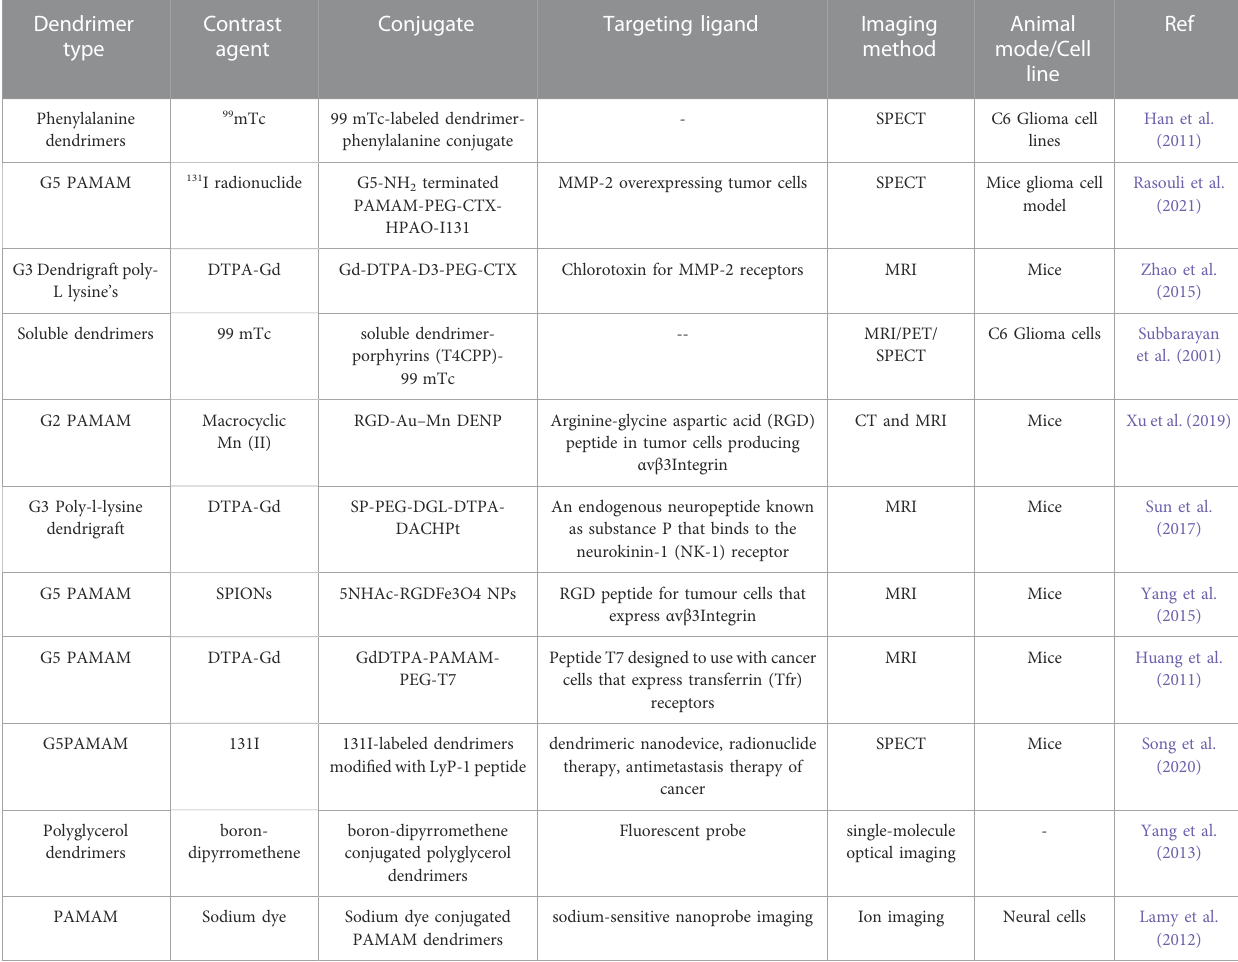
TABLE 3 Dendrimers used as contrast agents for